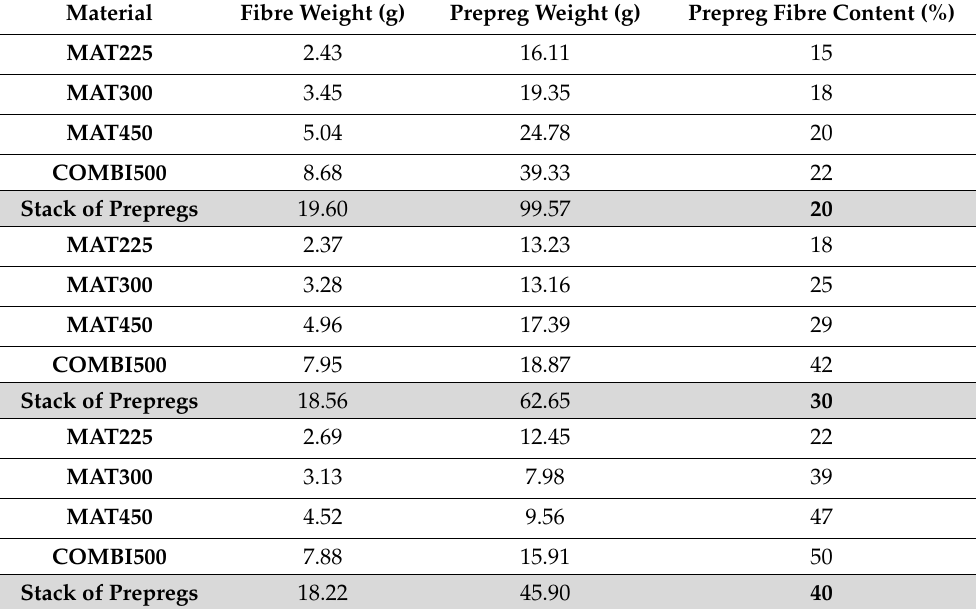
Table 1. Fibre content of the prepregs and the stacks of